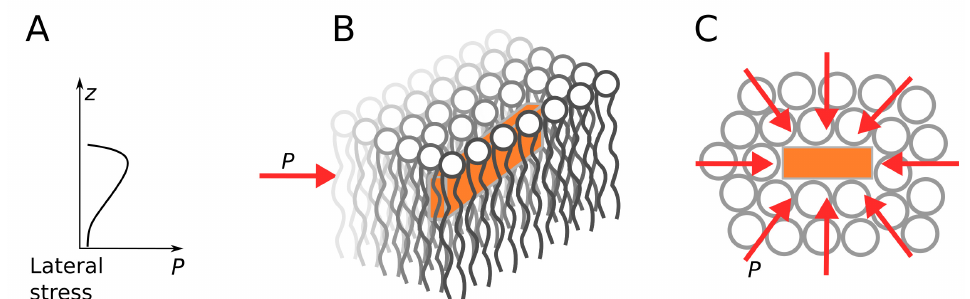
Figure 2. ( A ) Lateral pressure profile in the hydrophobic region. ( B ) Schematic representation of a molecule in the lipid layer; ( C ) same as ( B ), top view. The area of a molecule projection onto the plane perpendicular to normal bilayer should be